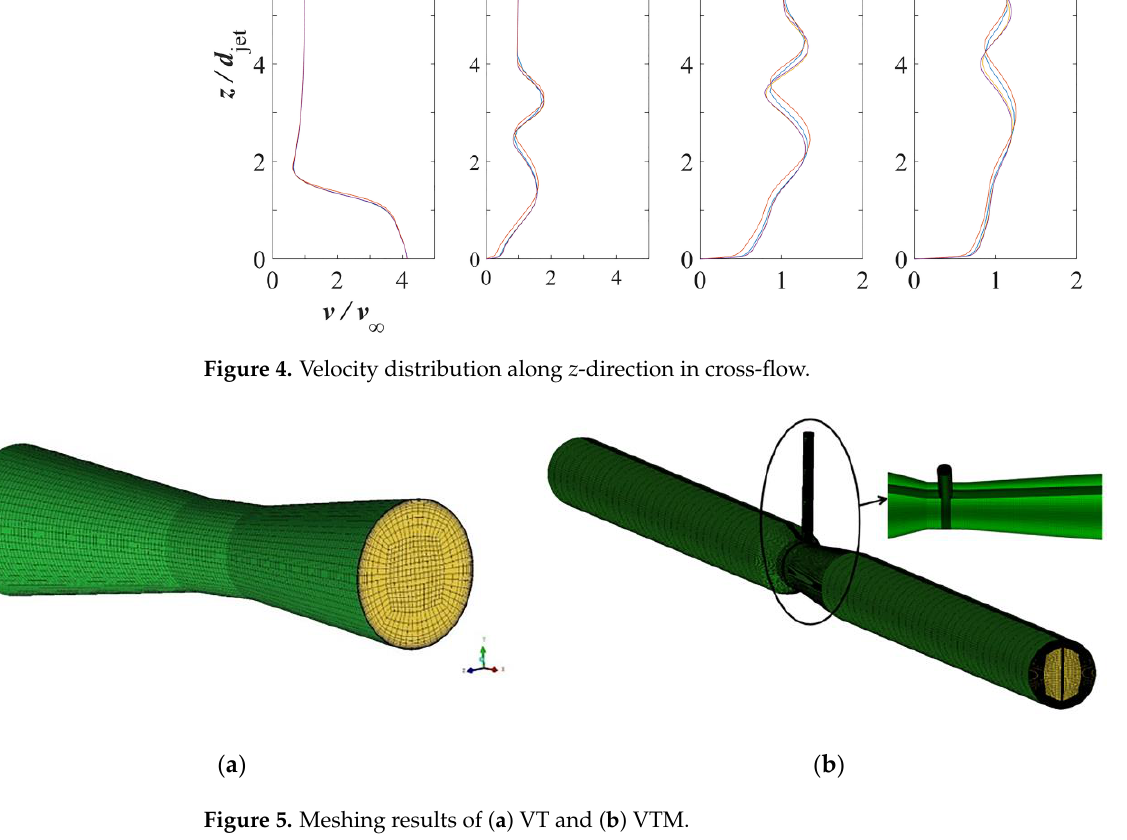
Figure 5. Meshing results of ( a ) VT and ( b ) VTM.